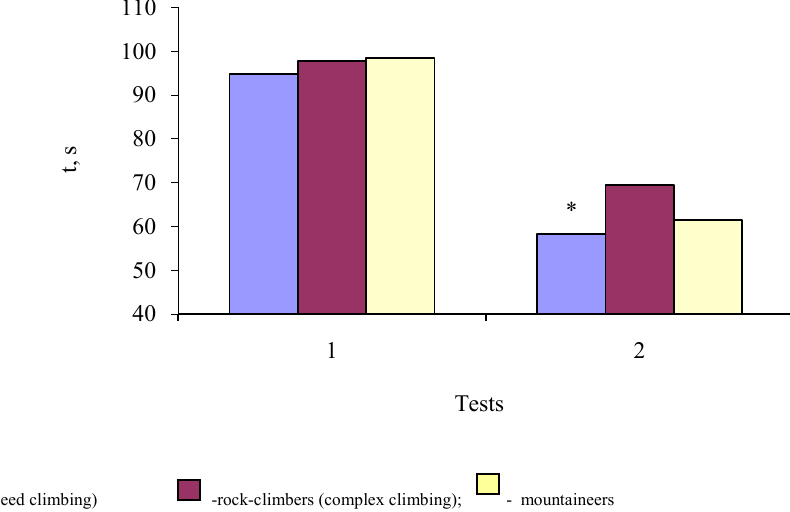
Fig. 3. Indicators of mobility of nervous system of elite athletes, specializing in speed climbing (n=10),climbing on complexity (n=10) and mountaineers